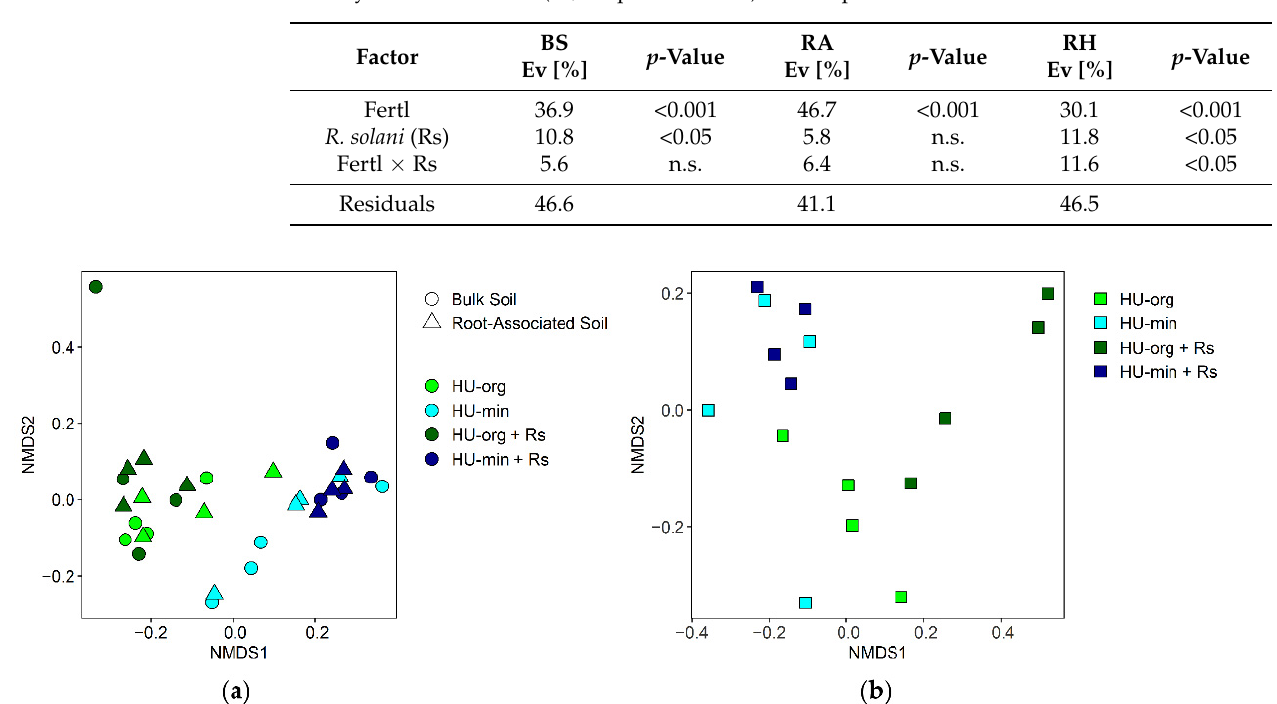
Figure 5. Non-metric multidimensional scaling (NMDS) of fungal communities ( a ) in bulk soil and root-associated soil (stress = 0.09), and ( b ) in the rhizosphere (stress = 0.11) of lettuce (cv. Tizian) depending on long-term fertilization strategy (HU-org—organic fertilization; HU-min—mineral fertilization) and the presence of Rhizoctonia solani AG1-IB (+Rs). Alpha diversity indices (species richness, Shannon index) were calculated to assess the effects of the studied factors on fungal communities in each habitat. A significant influence of fertilization strategy on the fungal diversity was found in root-associated soil, resulting in higher diversity indices in organic vs. mineral treatments (Supplementary Table S7).